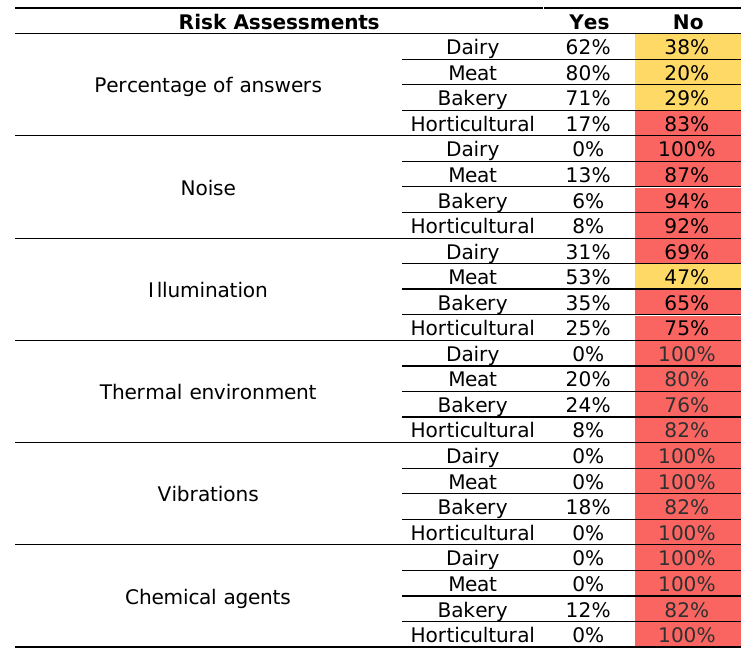
Table 3. Audited companies with specific risk